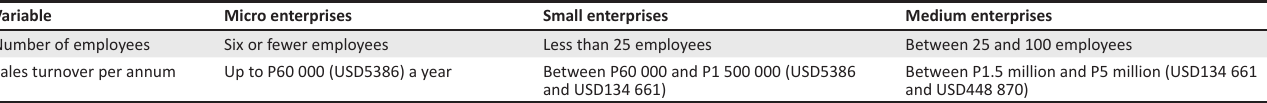
TABLE 1: Definitions of small, medium and micro-sized enterprises in